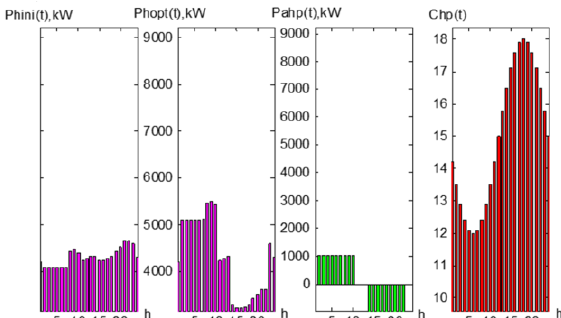
Fig. 3. Daily heat load